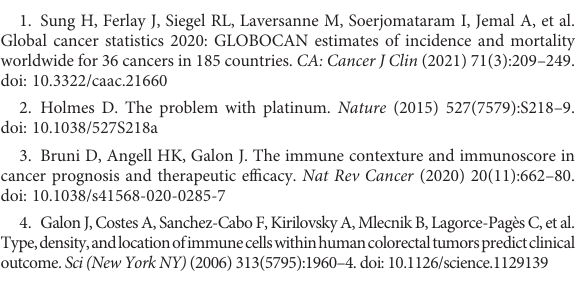
SUPPLEMENTARY FIGURE 1 Least absolute shrinkage and selection operator (LASSO) regression was performed, calculating the minimum criteria (A, B) and coef fi cients (C). SUPPLEMENTARY FIGURE 2 Time-dependent receiver operating characteristic (ROC) curves to predict the 5-year OS for the risk score, age and stage in TCGA-RNA- Seq cohort (A) and HG-U133_Plus_2 cohort (B) . SUPPLEMENTARY FIGURE 3 Difference between high-risk score group and low-risk score group in immune in fi ltration, immunotherapy and chemotherapy response prediction in HG-U133_Plus_2 cohort. The risk score was positively correlated with EstimateScore, ImmuneScore, StromalScore and negatively correlated with PurityScore (A-D) ; The Association of the signature and the distribution of 22 immune cells (E) ; Estimated IC50 values indicated the chemotherapy response of paclitaxel, metformin, veliparib and Cisplatin in TCGA-RNA-Seq cohort (F – I) . * p < 0.05 ; ** p < 0.01 ; *** p < 0.001 . SUPPLEMENTARY FIGURE 4 Molecular immune cell subtypes related to the fi ve immune-related lncRNAs in HG-U133_Plus_2 cohort (A) and TCGA-RNA-Seq cohort (B) , respectively. GSEA identify the different pathways between high-risk group and low-risk group in HG-U133_Plus_2 cohort (C) and TCGA- RNA-Seq cohort (D) , respectively. SUPPLEMENTARY TABLE 1 The primers in the study. SUPPLEMENTARY TABLE 2 The immune-related lncRNAs identi fi ed in TCGA-RNA-seq dataset and HG-U133_Plus_2